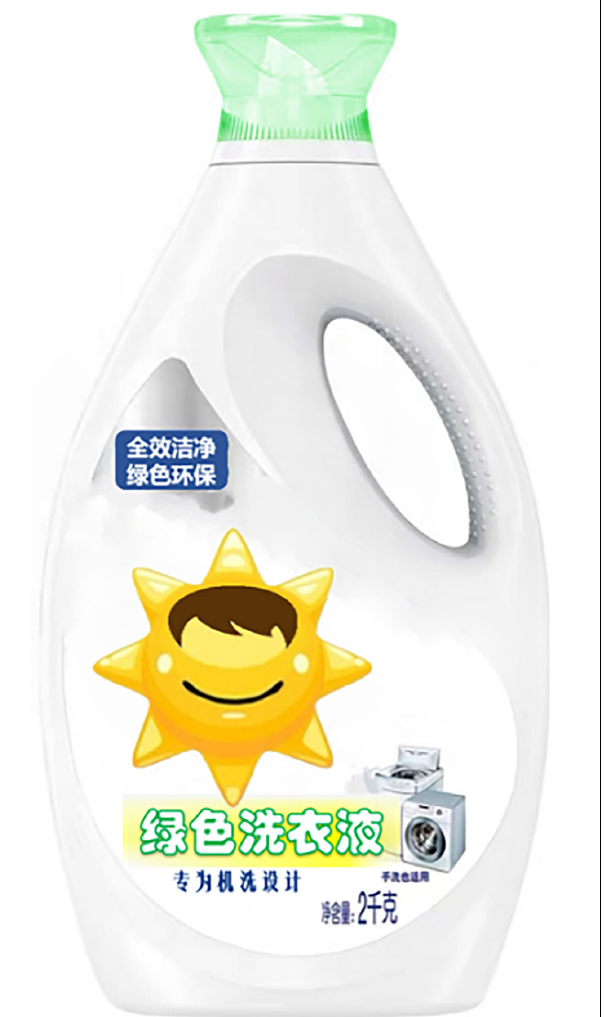
FIGURE 7 | Anthropomorphic strategy of happy expressions without